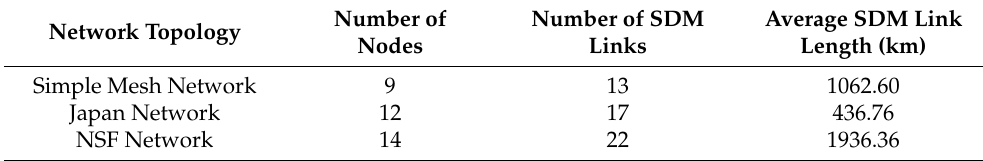
Table 4. Characteristics of the simulated network topology.